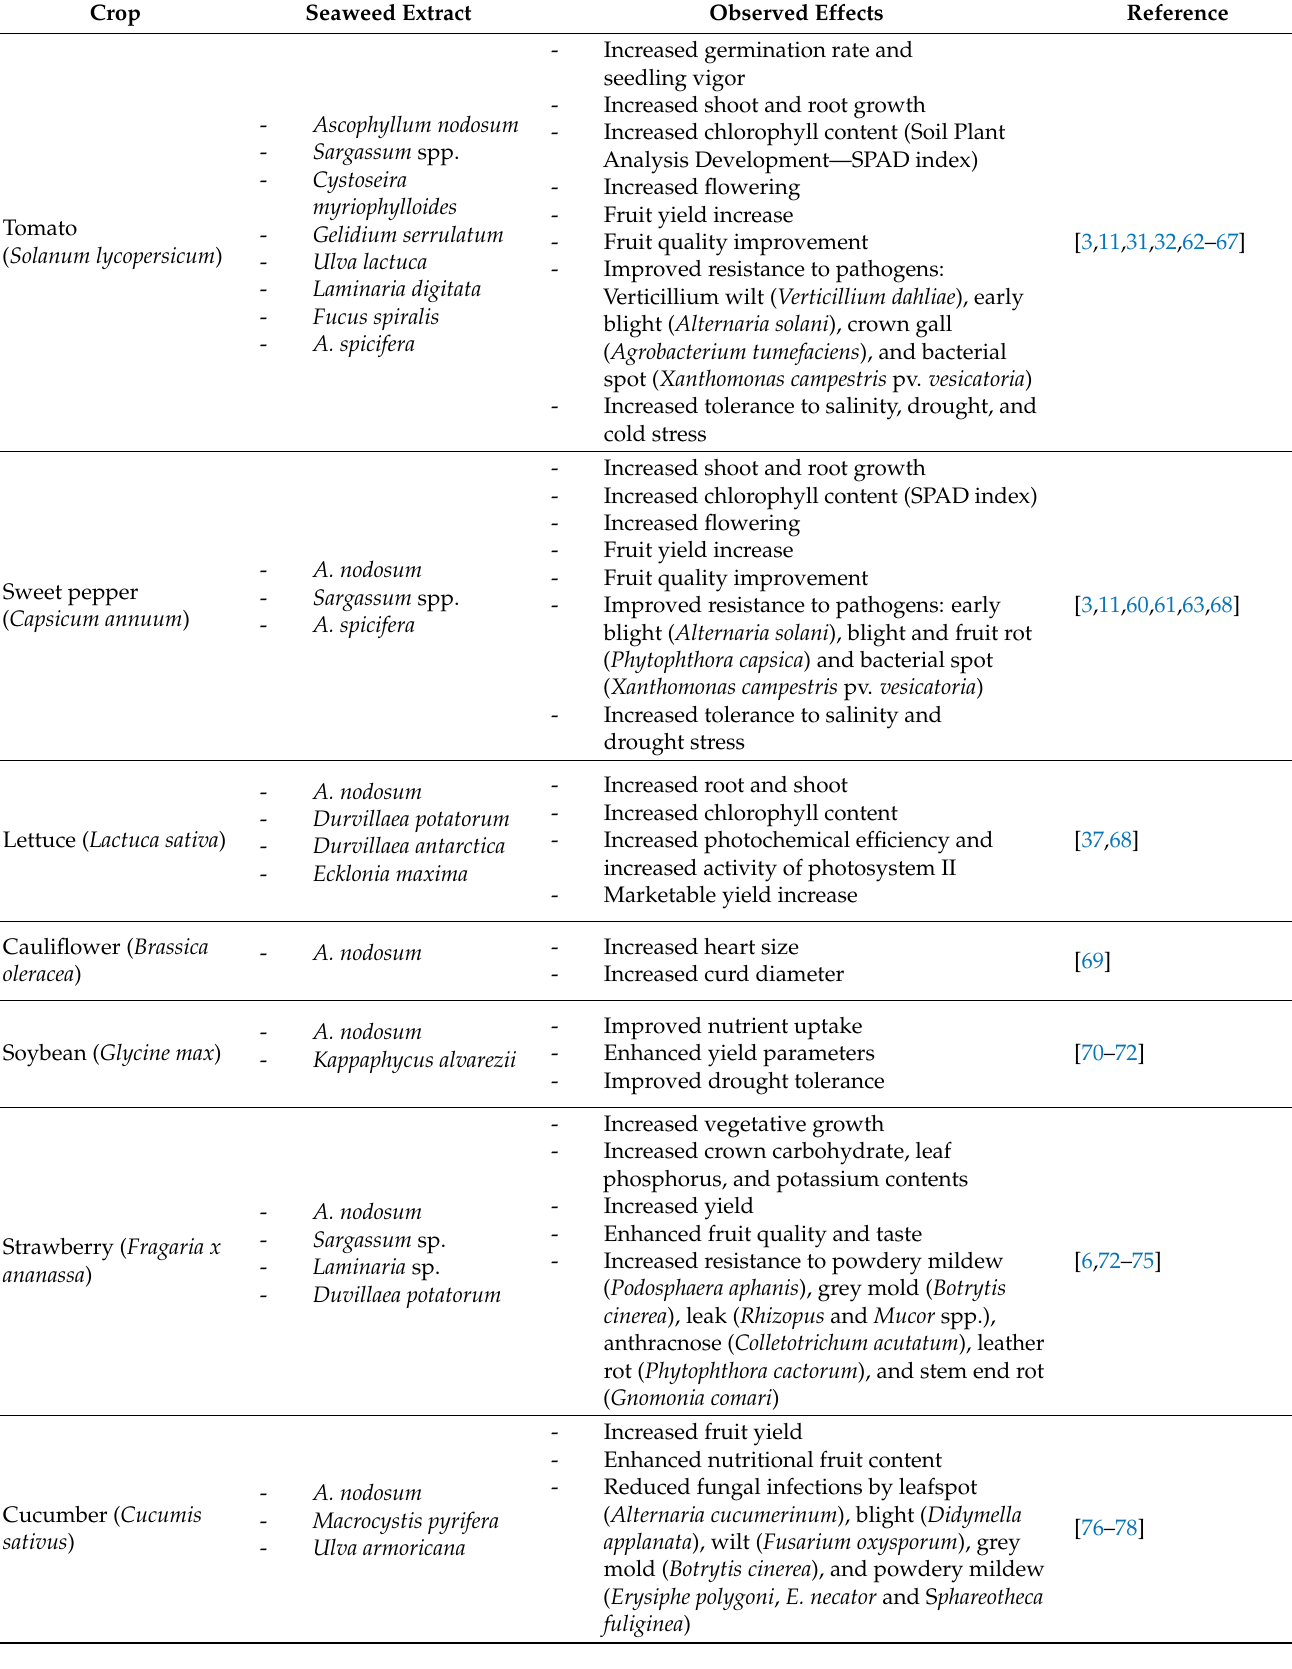
Table 2. Effect of seaweed extract biostimulants on major crops. Crop Seaweed Extract Observed Effects